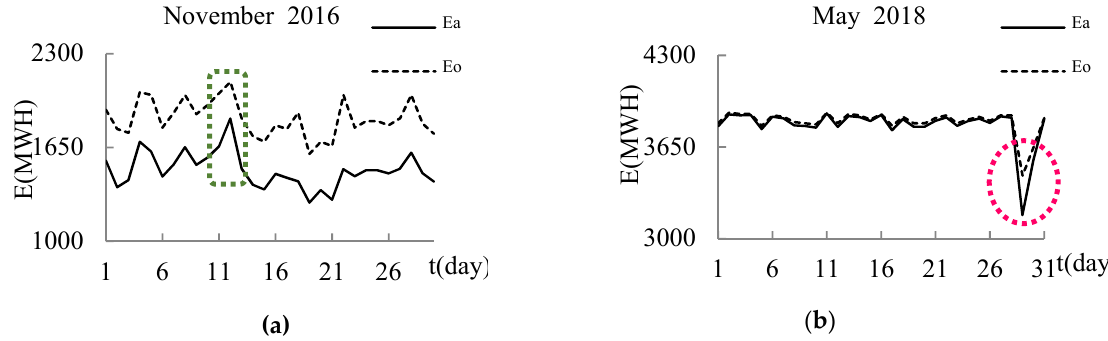
Figure 4. Optimal and actual power generation chart of January 2016 and February 2017.3.3. Power Generation Optimization.